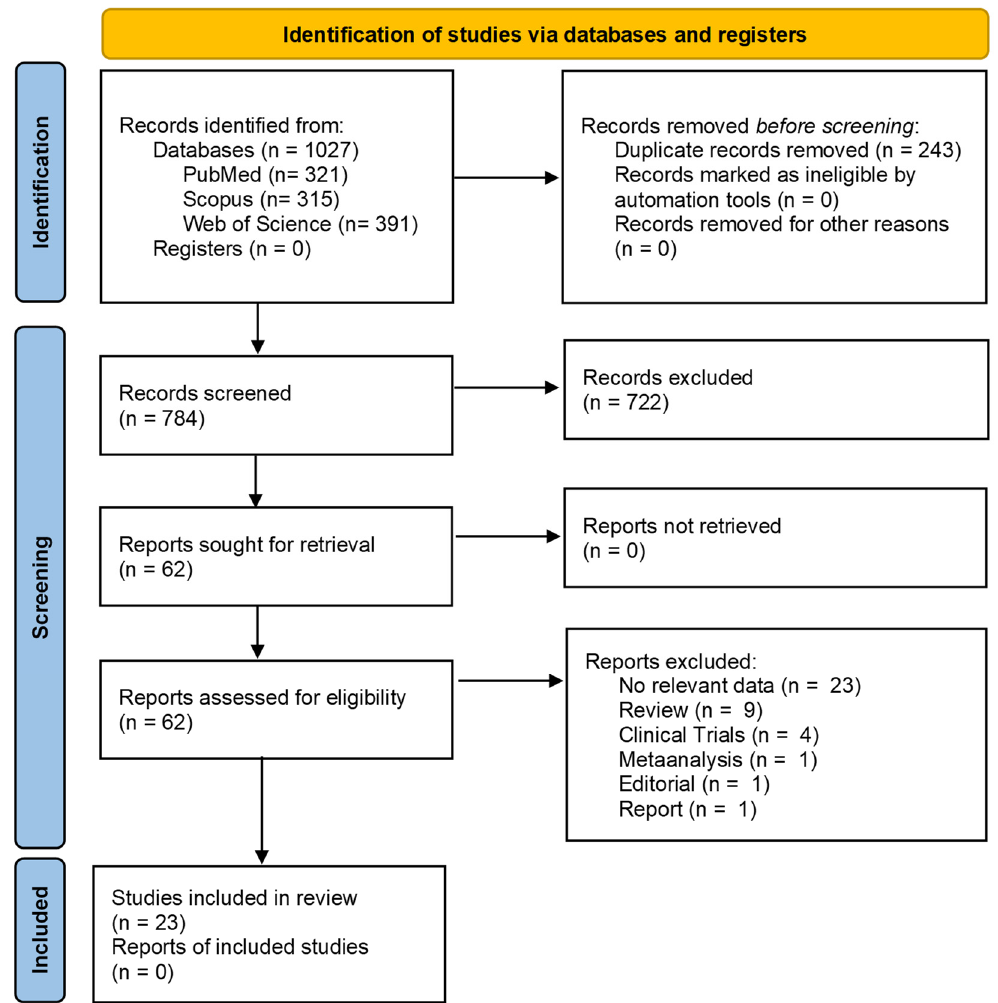
Figure 1. PRISMA flow diagram of the study research methodology in the literature. Adapted from PRISMA Group [27]. * Clinical studies, reviews, meta-analyses, editorials, opinion pieces, and articles not providing the effect of pain medicine on therapeutic response to BC, articles written in languages other than English, written before 2010 or unavailable as complete articles were excluded.